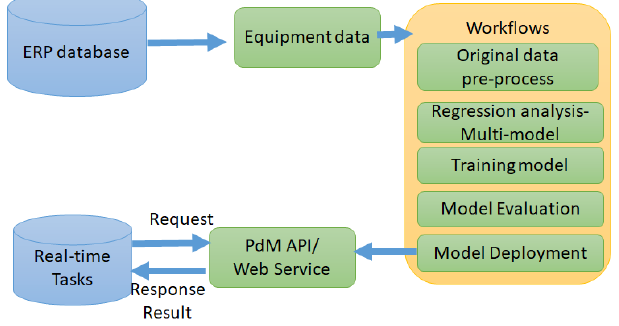
Figure 5. PdM procedure in the textile manufacturing process.